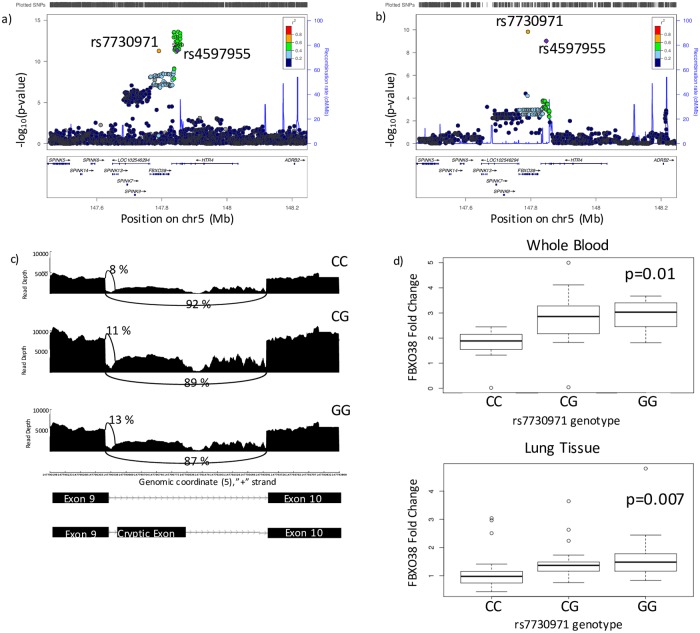
Colocalization analysis of sQTLs and COPD GWAS data at 5q32.a) Locus zoom plot of the GWAS association at 5q32. The secondary GWAS association at this locus consists of two SNPs–rs7730971 and rs4597955. The primary association is in moderate LD (R2 = 0.4–0.6) with this association. b) Locus zoom plot of sQTL data for the association between FBXO38 splicing with genotype. SNPs associated with FBXO38 splicing are located in HTR4 and FBXO38. c) Visualization of the FBXO38 splice site associated with rs7730971 genotype. The y axis shows read depth and the x axis shows genomic position on chromosome 5. Arched lines indicate junction spanning reads. There are fewer junctional reads supporting the presence of the cryptic exon in the CC genotype (8%) compared to the GG genotype (13%). d) Boxplot of qPCR results showing the fold change of the isoform containg the crypic exon compared to the CC genotype in whole blood (n = 30; selected based on expression levels) and lung tissue (n = 90, selected based on genotype). The center line indicates median, the box captures the interquartile range, and the whiskers show the range excluding outliers. P-values are from linear regression which was performed to test for an additive relationship between genotype and splicing ratio.